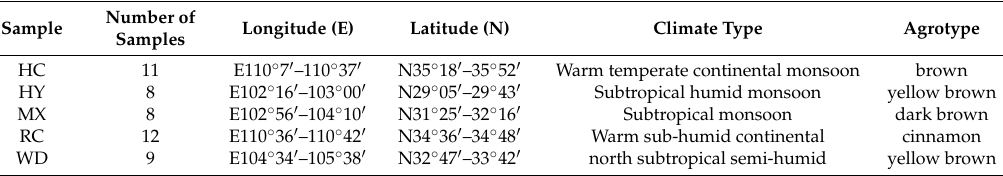
Table 5. Geographical sources of Chinese red